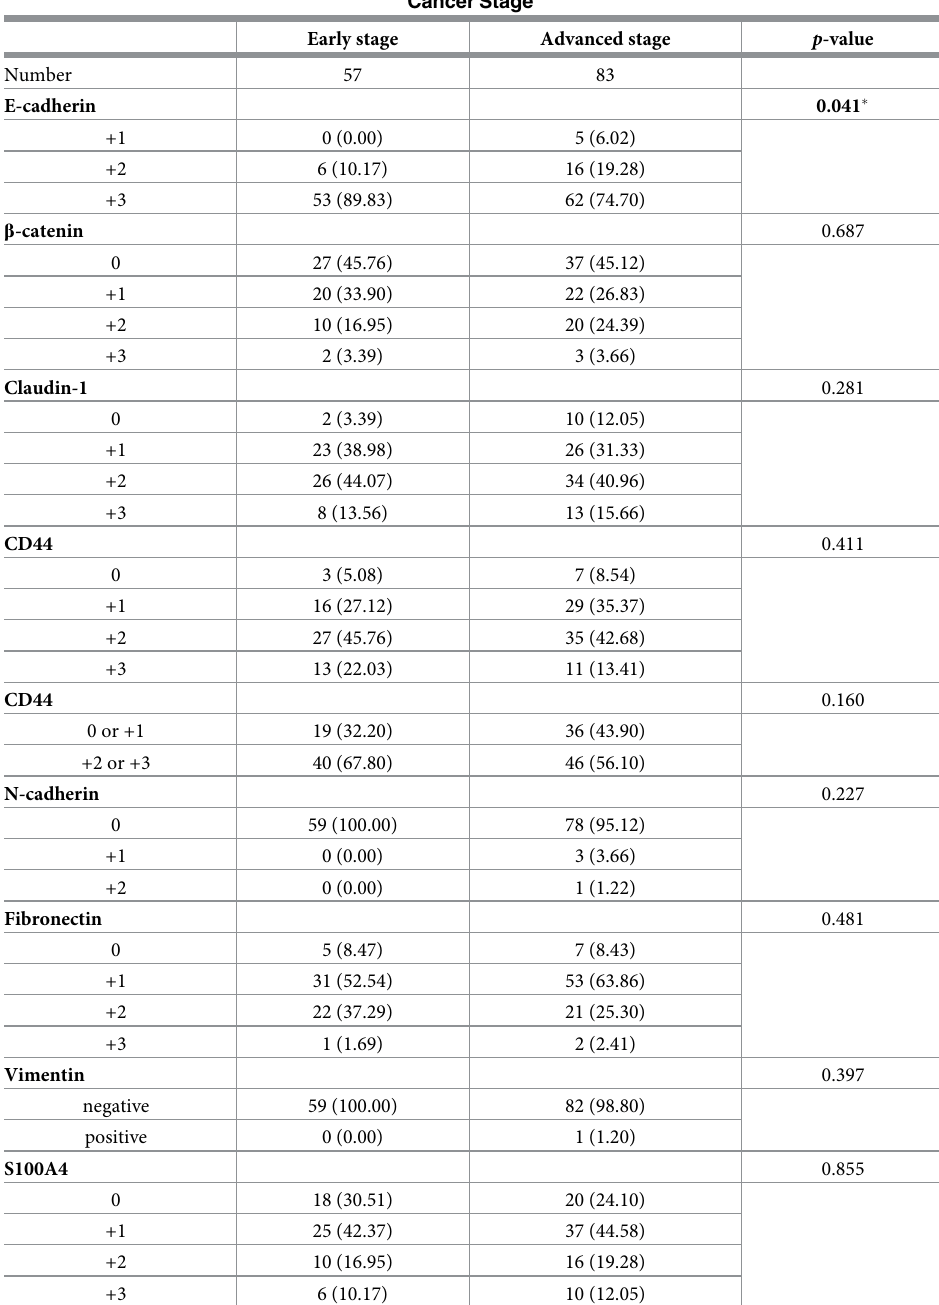
Table 5. IHC expression of EMT-related markers vs . cancer stages classified into early stage (stages 0 to II) and advanced stage (stages III to